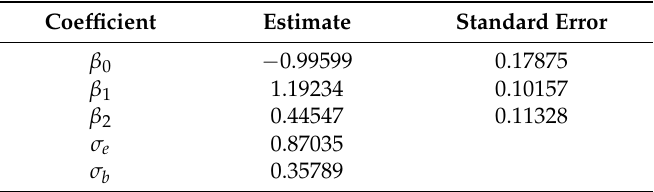
Figure 3. Scatter plots of fitted values against the standardized residual of the model for predicting total aboveground biomass. Table 2. Parameter estimates and their standard errors for the model used to predict total AGB (Equation (3)) of small DBH trees. β i (cid:48) s ( i = 0, 1, 2 ) are regression coefficients and σ e and σ b are variance components of mixed models.